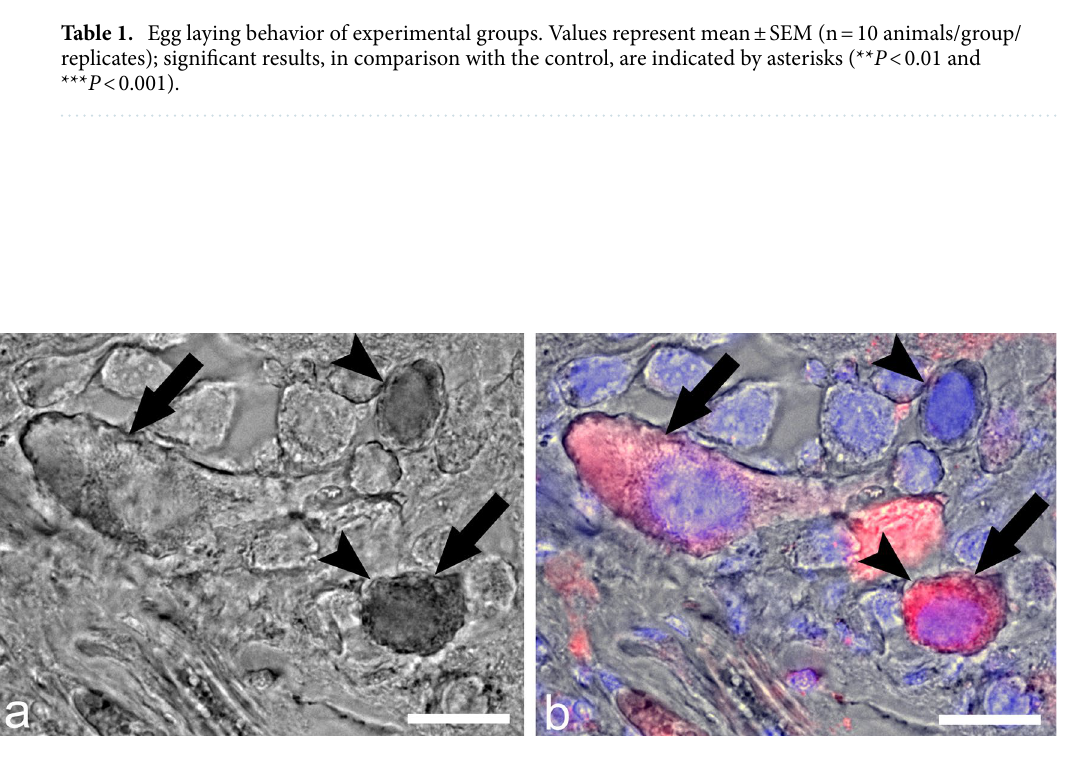
Figure 4. Double-labeling of ly-GnRH/CRZ neurons in the anterior lobe of the right cerebral ganglion by IHC and nickel-lysine backfill. ( a , b ) represent the same section. The section after nickel backfill was visualized without ( a ) and with ( b ) IHC imaging. Red color: ly-GnRH/CRZ immunostaining; blue color: nuclei staining. Arrow represents a ly-GnRH/CRZ-ir neuron. Arrowhead indicates a backfilled neuron. The double-labeled neuron is labeled by both arrow and arrowhead. Scale bar = 25